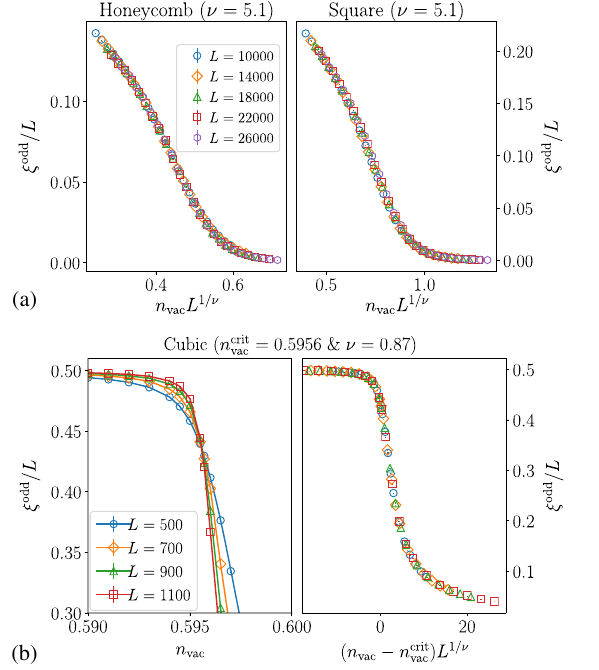
; L Þ , the correlation length FIG. 19. (a) Data for ξ odd ð n vac corresponding to the odd analog C odd ð r − r 0 Þ of the sample- averaged geometric correlation function in two-dimensional L × L samples at various values of n , collapse onto a single scaling FIG. 20. (a) For appropriate choices of ν and η , the suscep- vac L 1 = ν for small curve when ξ odd =L is plotted as a function of n tibilities χ odd associated with the odd analog C odd ð r − r 0 Þ of the vac values of n . (b) Same quantity on three-dimensional L × L × L sample-averaged geometric correlation function constructed from vac cubic lattices, plotted as a function of n . Note that curves just odd R -type regions of two-dimensional L × L samples, vac corresponding to different L display a sharp crossing at a when rescaled by L 2 − η , collapse onto a single curve when plotted ≈ 0 . 6 . Right panel: Data for ξ odd =L from L 1 = ν for small n threshold n crit near n as a function of n . (b) The masses m odd of vac vac vac vac max L × L × L cubic lattices in the vicinity of this threshold collapse the largest, odd R -type region in two-dimensional L × L sam- onto a single scaling curve when plotted as a function of the ples, when rescaled by L d= 2 þ 1 − η = 2 with d ¼ 2 , show analogous − n crit Þ L 1 = ν . This may be compared with scaling variable ð n scaling behavior. This may be compared with results discussed in vac vac results discussed in Sec. VII. Sec.